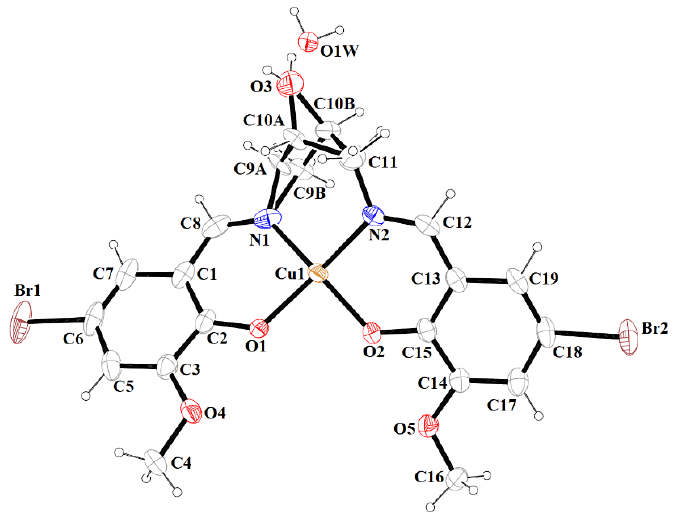
Figure 4. Part of the crystal structure of complex 1 showing O – H···O hydrogen bonds and formation of the 1D chain along the a direction.